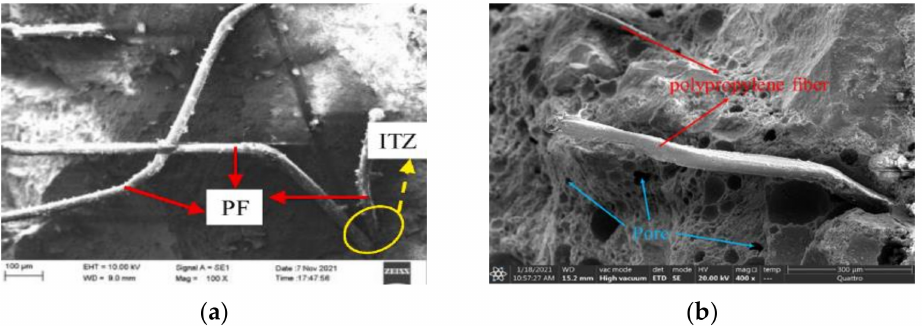
Figure 9. Distribution of PP fibers in concrete: ( a ) [28]; ( b ) [94].